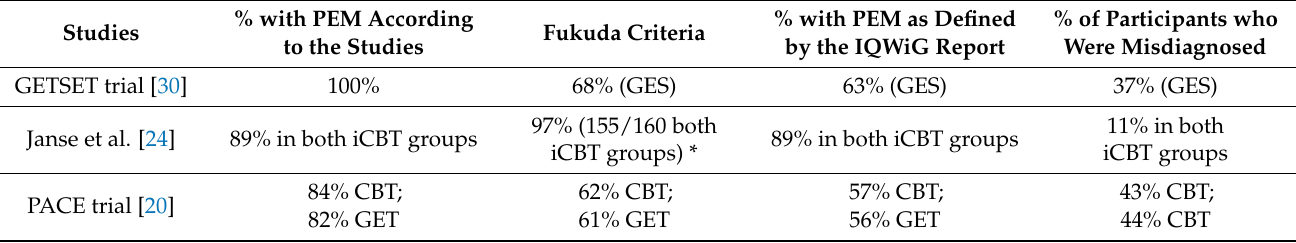
Table 1. Percentage of patients with PEM, ME/CFS and percentage of misdiagnosed